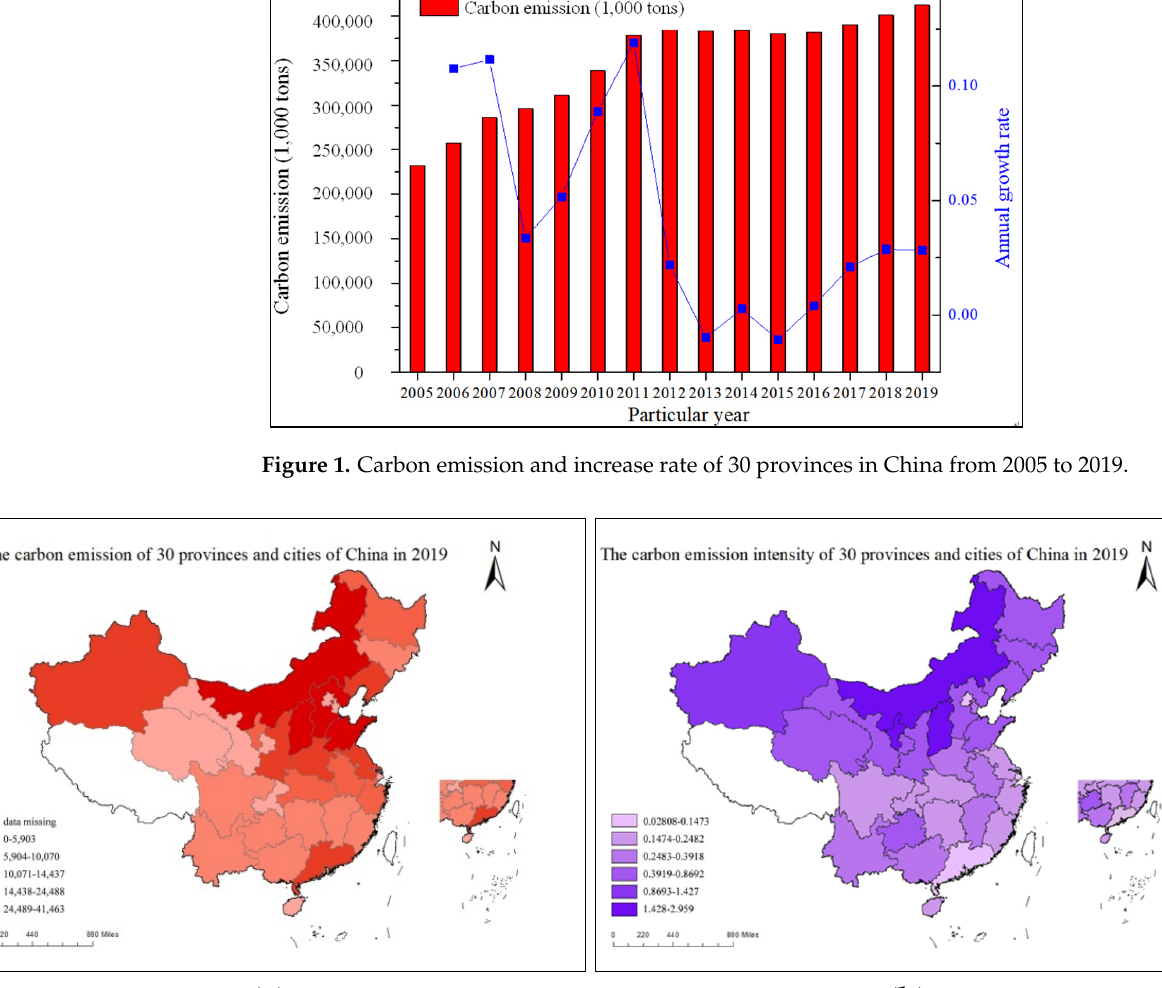
Figure 2. ( a ). Carbon emission of 30 provinces and cities of China in 2019. ( b ). Carbon emission intensity of 30 provinces and cities of China in 2019.